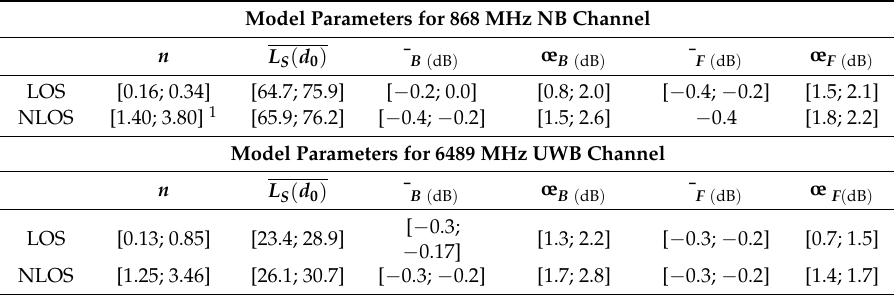
Table 7. Generalized parameters of the system loss model for an off-body communication in the ferryboat